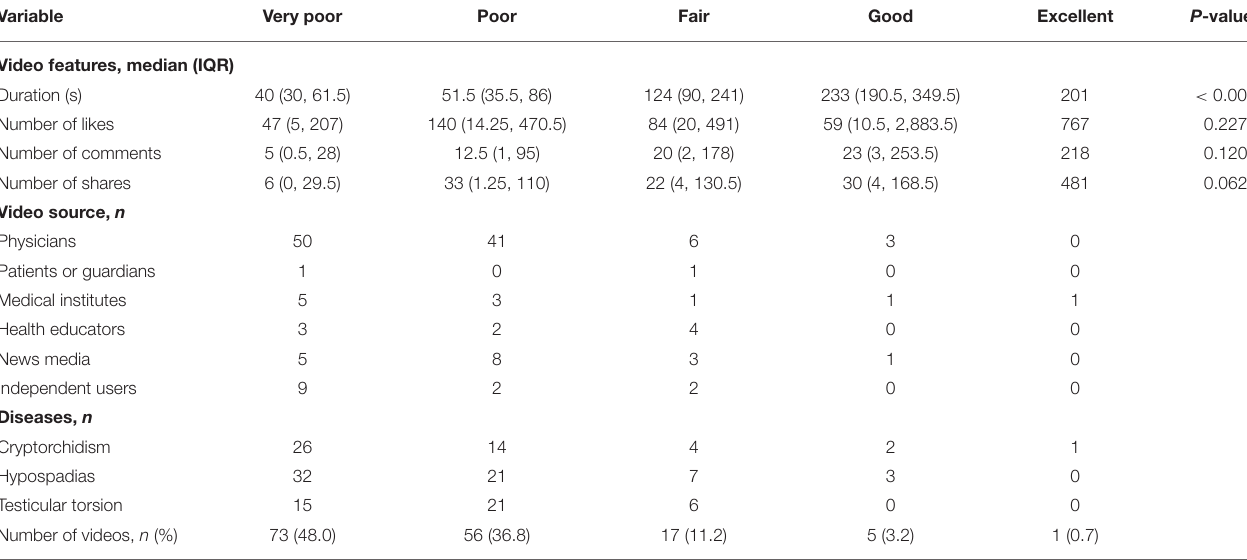
TABLE 4 | Distribution of DISCERN classification according to video features, source, and diseases. Variable Very poor P -value